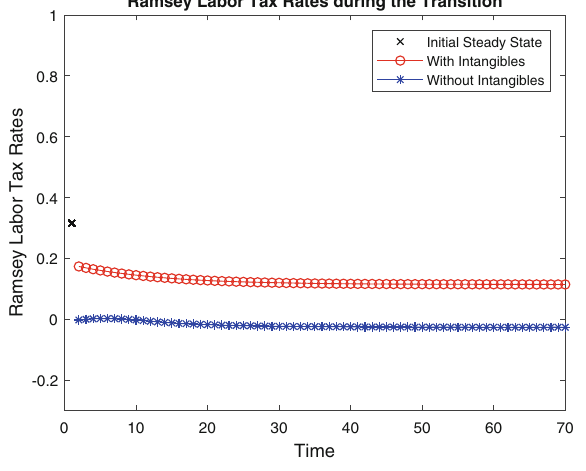
Fig. 3 Ramsey labor tax rates during the transition